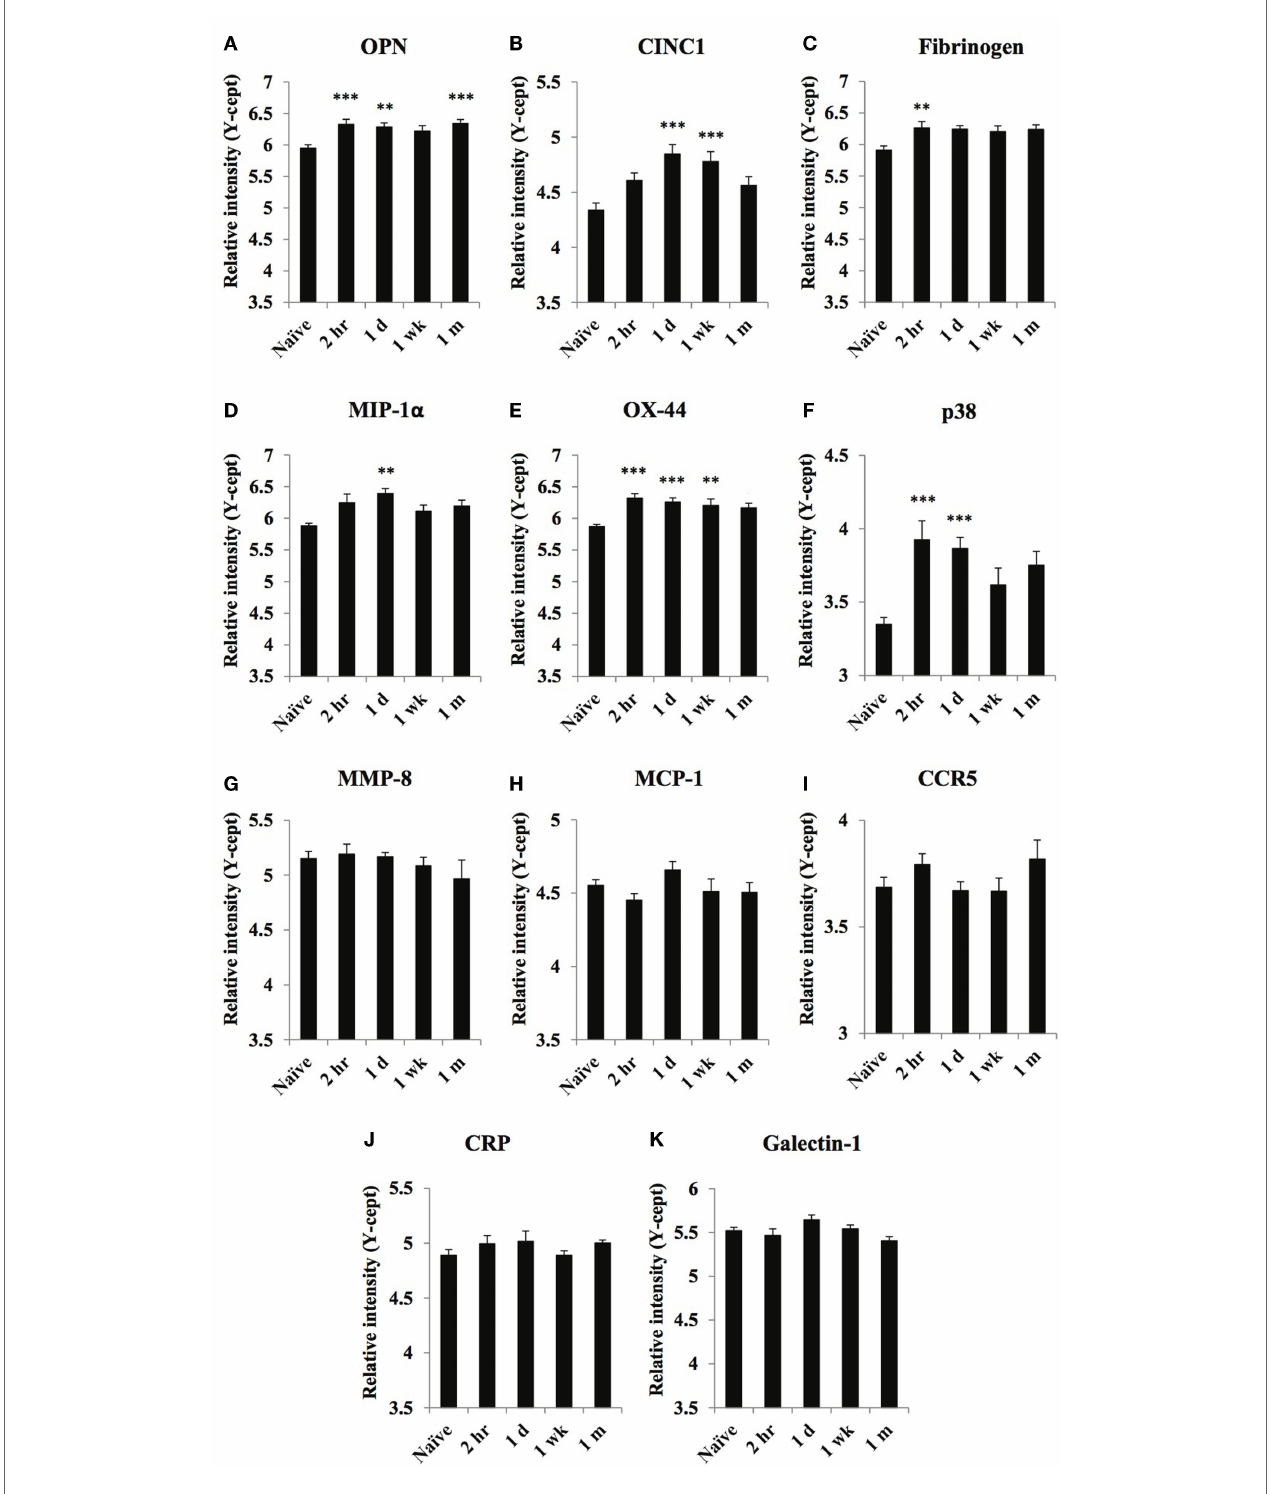
MCP-1 (h) , CCR5 (i) , CRP (J) , and galectin-1 (K) were assayed using reverse phase protein microarray (RPPM) and are expressed as y -cept values (log 10). Data are presented as the mean ± SEM; ** p < 0.01, *** p <